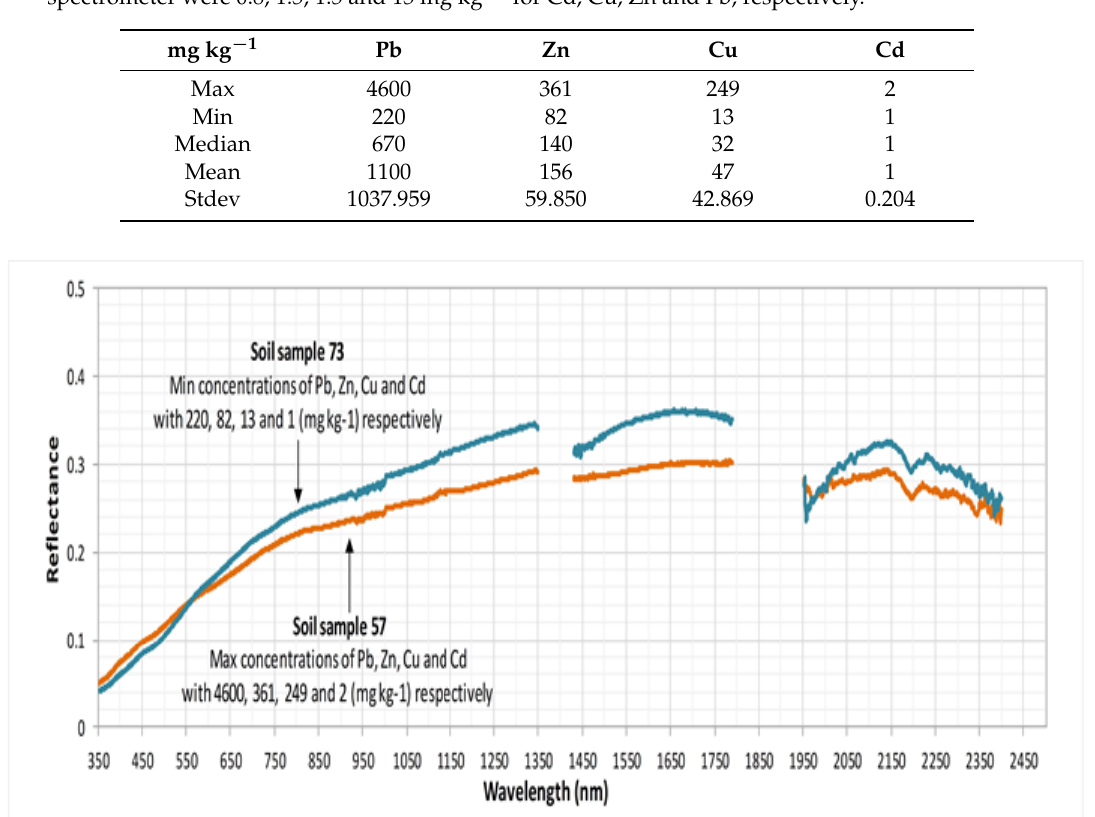
Table 1. Descriptive statistics of heavy metal concentrations in the soil of the contaminated area in Bow Street, UK, based on 85 samples. Max, Min, Median, Mean and Stdev are maximum, minimum, median, mean and standard deviation, respectively. The minimum detection limits of the atomic absorption